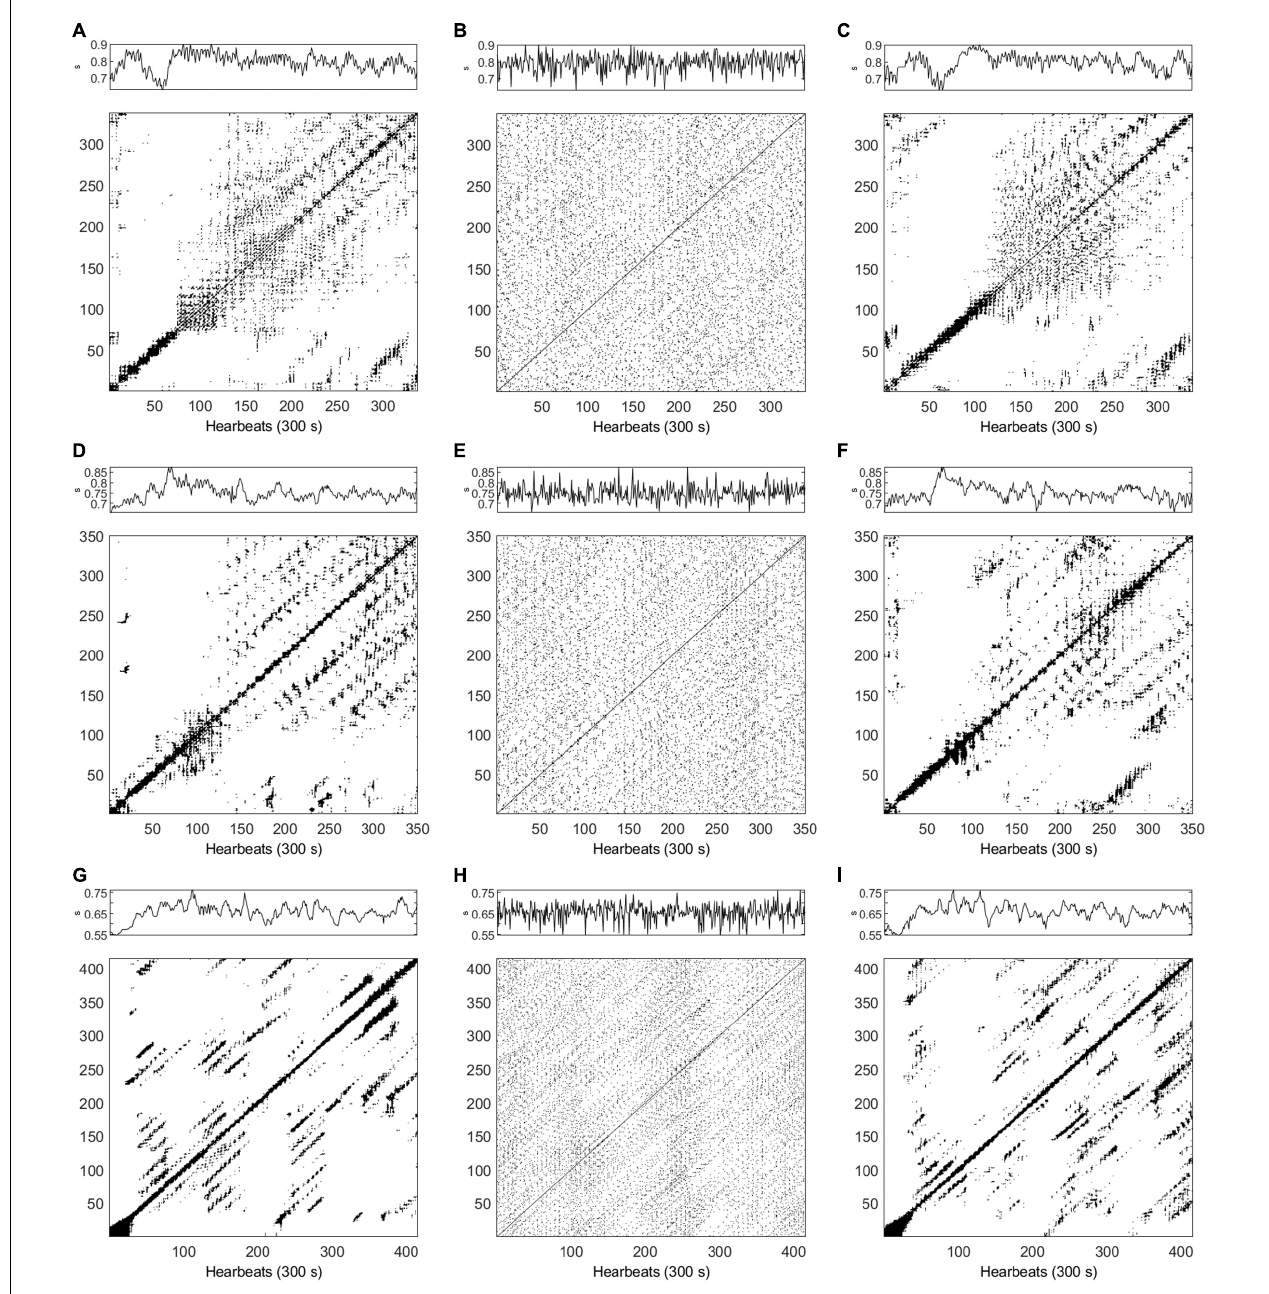
FIGURE 7 | (A–I) Examples of time series and recurrence plots for heart rate variability (HRV) data in active standing. Top row corresponds to a healthy subject ( m = 5, τ = 10), (A) original data, (B) Iterative Amplitude Adjusted Fourier Transform (IAAFT) surrogate, and (C) Pinned Wavelet Iterative Amplitude Adjusted Fourier Transform (PWIAAFT) surrogate. Middle row, end stage renal disease (ESRD) patient before hemodialysis (HD) ( m = 6, τ = 10), (D) original data, (E) IAAFT surrogate, and (F) PWIAAFT surrogate. Bottom row, ESRD patient after HD ( m = 8, τ = 6), (G) original data, (H) IAAFT surrogate, and (I) PWIAAFT surrogate. HRV time series units in all panels are shown as seconds